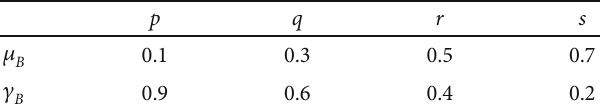
Table 20: Intuitionistic fuzzy set B :